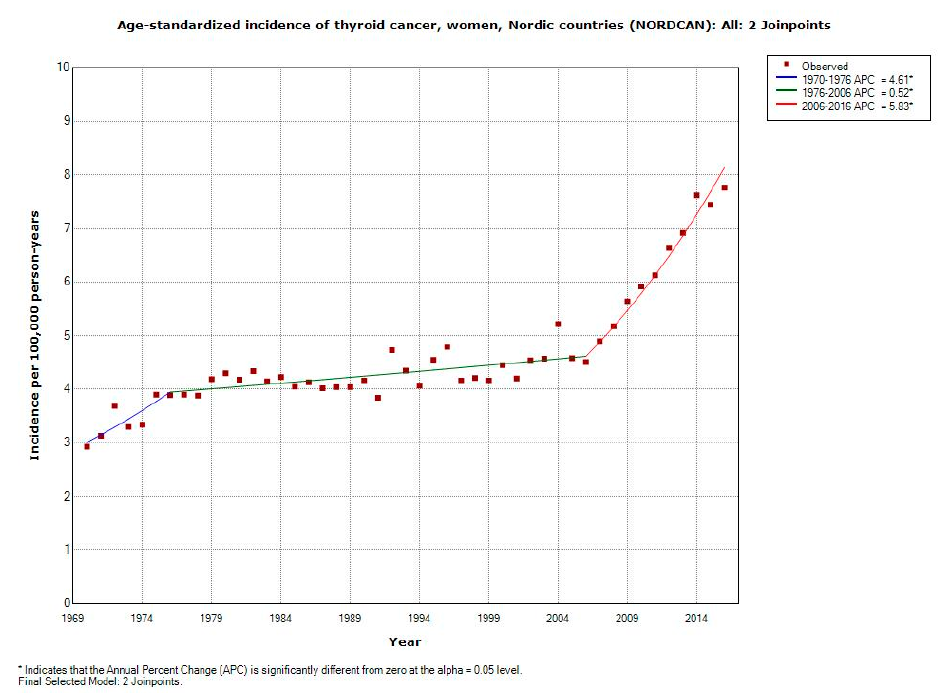
Figure 3. Joinpoint regression analysis of age-standardized incidence of thyroid cancer for women, all ages 1970–2016. Incidence per 100,000 inhabitants for ICD-10 code C73 in the Nordic countries according to NORDCAN (https://www-dep.iarc.fr/NORDCAN/english/frame.asp).